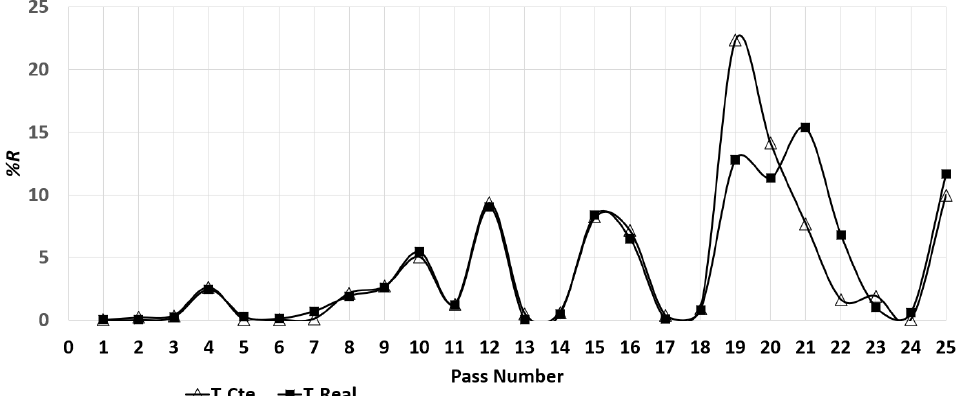
Figure 10. Evolution of the reduction of area (% R ) for the